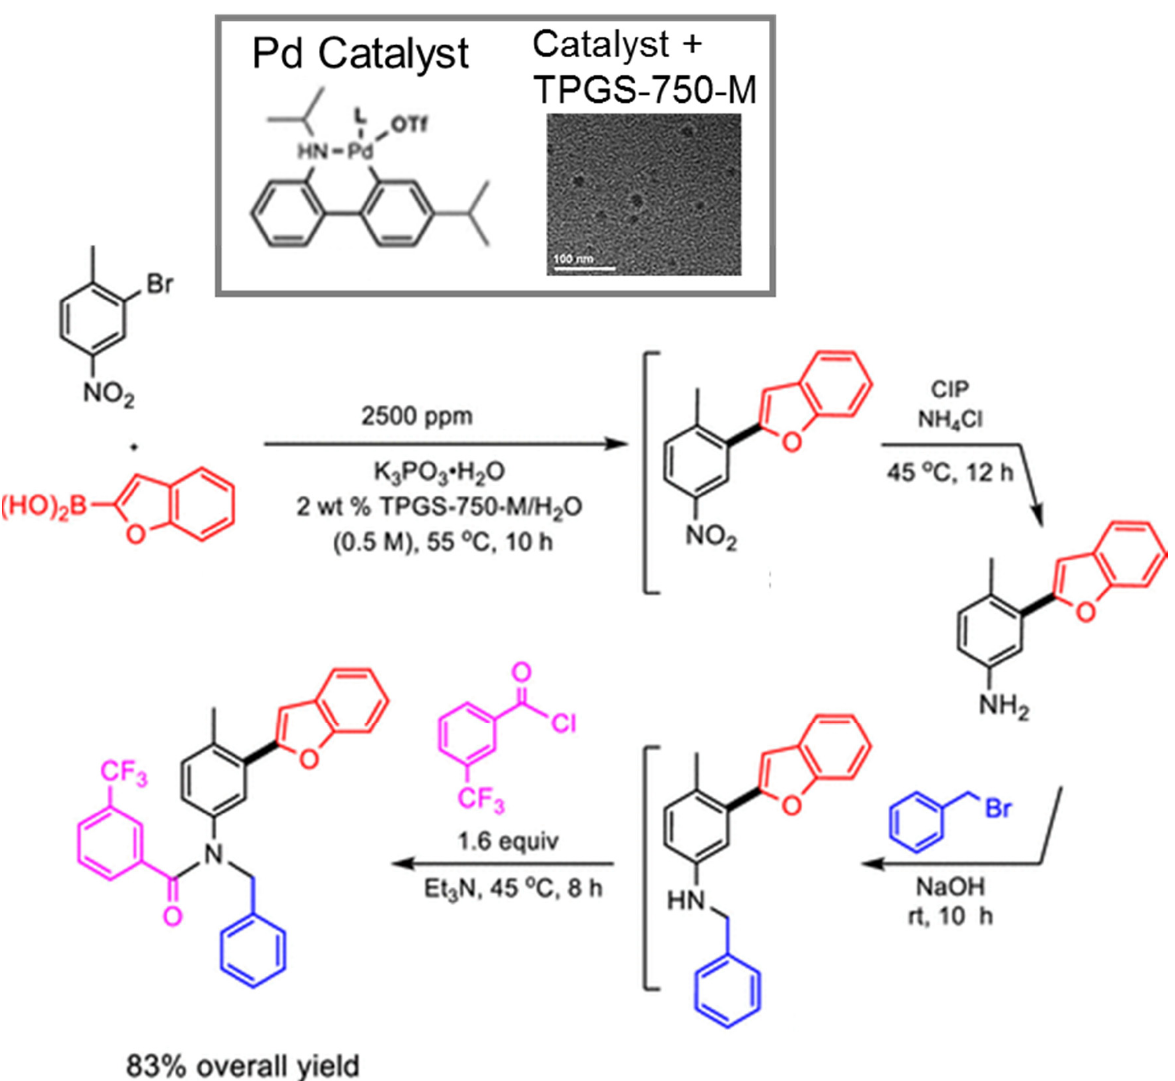
Figure 8. One-pot, four-step reaction sequence: (1) Suzuki-Miyaura coupling (Pd-catalyzed), (2) nitro-group reduction, (3) N-alkylation, and finally, (4) acylation in water using TPGS-750-M without isolation of intermediates. Bold indicates bond formation. The colors indicate how the reactants from each step were attached to form the final product. The final product was achieved with an 83% yield. The final product was isolated by extraction and flash chromatography. Adapted with permission from [126].